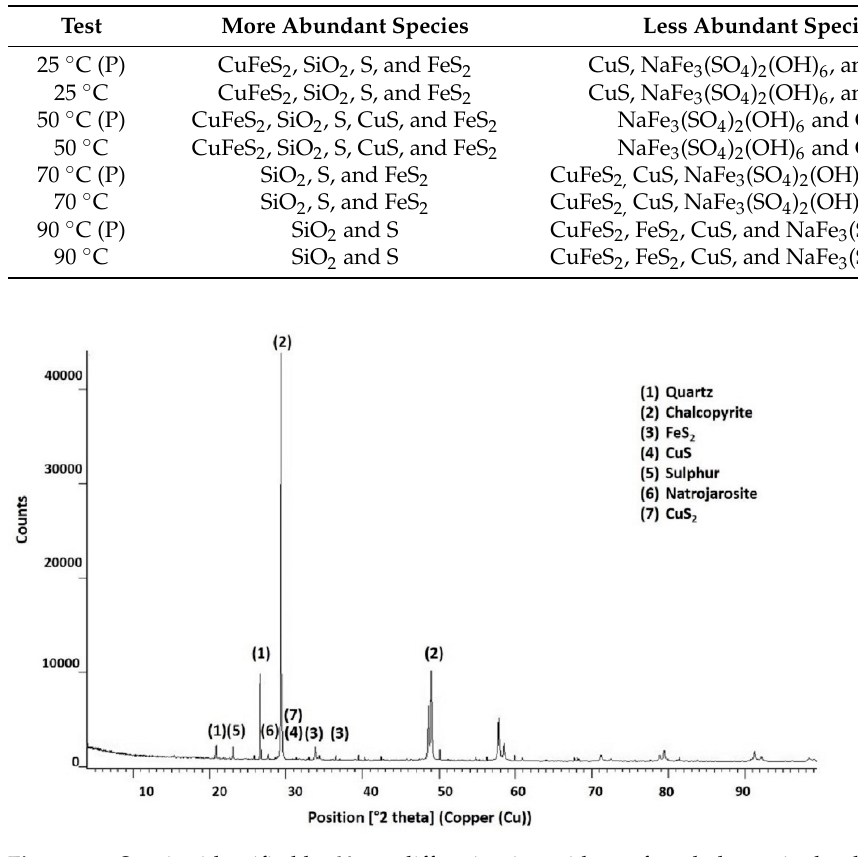
Figure 17. Species identified by X-ray diffraction in residues after chalcopyrite leaching at 90 °C after pretreatment with 15 kg/t of H 2 SO 4 and 25 kg/t of NaCl and 15 days of curing. The presence of copper and sulphur around the chalcopyrite were associated with CuS 2 or a similar polysulphide. The passivation associated with polysulphides (CuS 2 ) is explained in terms of the selective dissolution of iron as in a conventional process to form a thick layer of copper polysulphide over time. Additionally, in all the tests at 70 °C, the oxidation–reduction potential was measured in the range of 600–700 mV (SHE). This range is considered appropriate to form CuS 2 or other polysulphides [48]. While Figure 19 shows an abundance of elemental sulphur, the authors, including [49] with chalcopyrite leaching tests at 68 °C, proposed that the elemental sulphur formed during chalcopyrite dissolution is porous and does not contribute to the passivation of the surface of chalcopyrite. The authors proposed that species, such as jarosite, are responsible for passivating chalcopyrite. Based on tests at 90 °C using FeCl 3 and HCl, other researchers [53] indicated that the elemental sulphur layer formed on the chalcopyrite surface after leaching in a ferric chloride solution is porous and is not a barrier to further leaching. The results obtained in the present study confirmed that the porosity of the products layer increased with temperature.